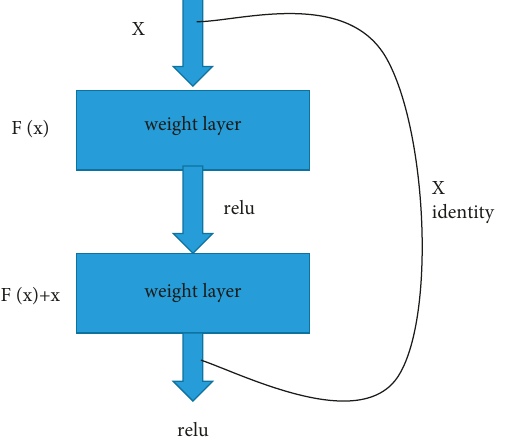
Figure 4: Residual learning module.